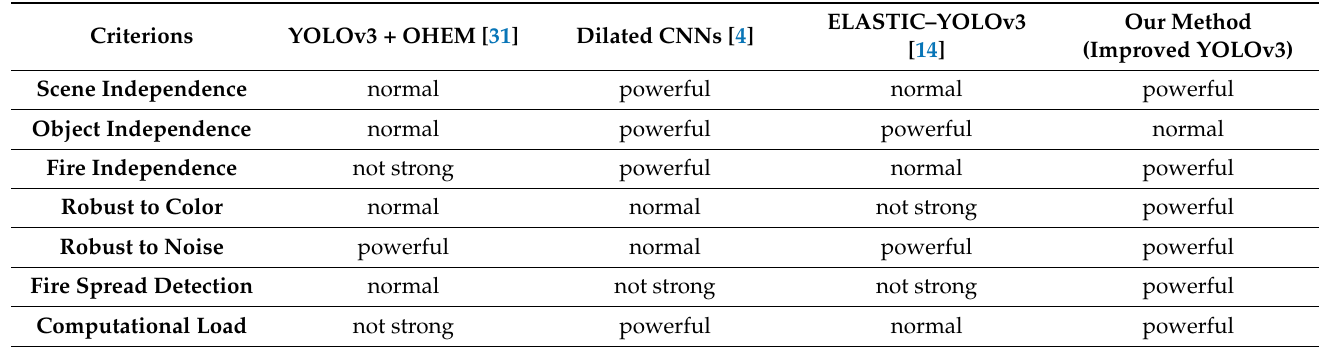
Table 8. Fire detection performance review using various features.